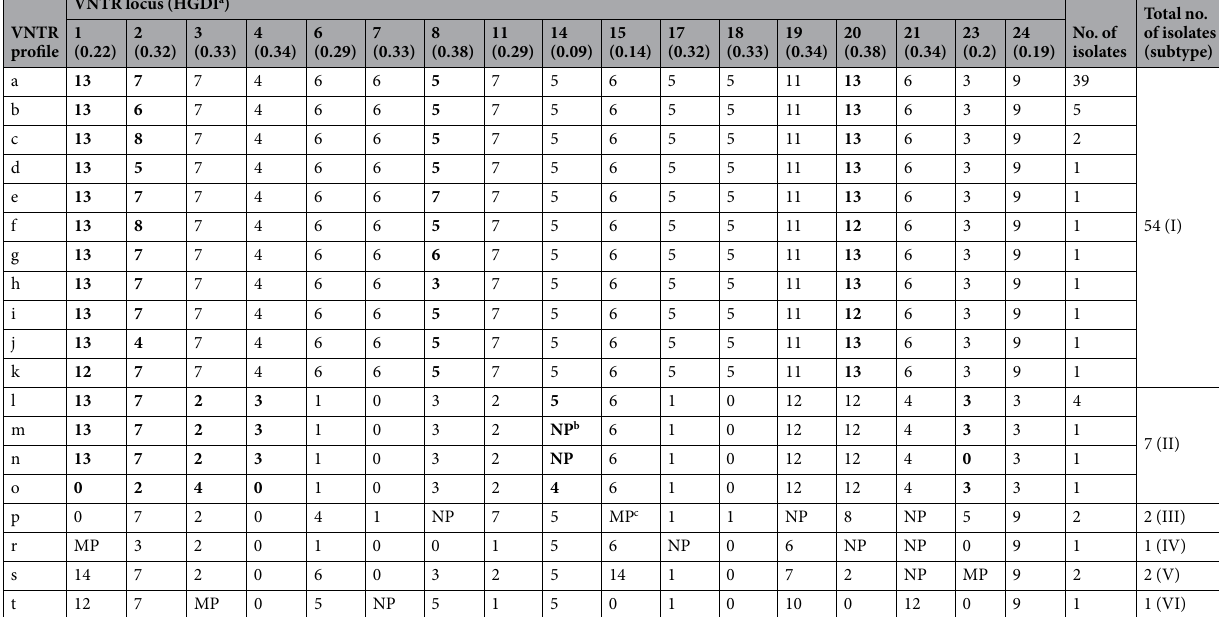
number of copies calculated from the gel analysis of PCR products. Sequence analysis confirmed also the electrophoretically-deduced copy number at locus VNTR 24 for M. kansasii types I, II, and IV and VI. PFGE. Three restriction endonucleases, that is AseI, DraI, and XbaI were attempted in PFGE profiling. Whereas, the latter two consistently resulted in DNA band smearing, thus making the profiles unreadable (data not shown), the use of AseI provided good-quality restriction patterns with clear band separation. PFGE with AseI was performed on the entire study sample (67 isolates). PFGE produced 33 distinct patterns, each consisting of 11–24 bands with sizes ranging between 48.5 to 485 kb. The patterns were separated into 12 clusters, each containing 2–9 isolates, and 21 unique patterns (GDI = 0.49; HGDI = 0.95) (Table 2, Suppl. Figure 1). The CR of the PFGE analysis was calculated at 68.6%. Fifty-four M. kansasii subtype I isolates formed 25 different profiles split into 8 clusters and 17 unique patterns (GDI = 0.46; HGDI = 0.93). Of the clusters, the most abundant were F and H, each comprising 9 isolates (9/54; 16.7%), followed by R and U, of four isolates, each (4/54; 7.4%), M, S, and X, each with three isolates (3/54; 5.6%), and D with two isolates (2/54; 3.7%). Among seven M. kansasii type II isolates, there were two clusters (AC, AE), with two isolates, each (2/7; 28.6%), and three unique profiles (GDI = 0.71; HGDI = 0.9). Type III ( n = 2) and IV ( n = 1) isolates shared identical PFGE pattern (AI), whereas type V ( n = 2) and VI ( n = 1) isolates had type-specific profiles, that is AB and L, respectively. Although some clusters were homogenous with respect to isolate’s geographical origin (e.g. F, R, U, AC, AE), source of recovery (clinical/environmental) (e.g. F, H, R, U, AB), and clinical relevance (e.g. S, AC, AE), clusters allocating isolates of different pathogenic status (F, H, R, U, X), from different countries (H, M, AI, AB) or sources (M, AI) were also observed. Combined analysis. Four (“a”, “b”, “c”, “l”) of the six VNTR clusters were subdivided by PFGE analysis (Table 3 ; Fig. 2). Within a major VNTR cluster “a”, comprising 39 isolates, 23 distinct pulsotypes (A-J, M-Z, AG, AH) could be distinguished. PFGE also differentiated within VNTR clusters “b” (5 isolates), “l” (4 isolates), and “c” (2 isolates), creating three (U, X, AA), two (AC, AE), and two (F, M) pulsotypes, respectively. Contrariwise, of 12 PFGE clusters, nine (D, F, H, M, R, S, U, X, AI) were further separated upon VNTR typing (Table 3). Two major pulsotype clusters (F and H), of nine isolates each, could be subdivided into four (“a”, “c”, “e”, “f”) and two (“a”, “h”) VNTR clusters, respectively. Clusters R and U, each comprising four isolates, were both split into two VNTR clusters (“a”, “j” and “a”, “b”). A three-isolate cluster M and a two-isolate cluster D were split into three (“a”, “c”, “k”), and two (“a”, “d”) VNTR clusters, accordingly. Patterns S, X, and AI, each with three isolates, were subdivided into two different VNTR clusters (“a”, “i”; “m”, “b”; “p”, “r”). A combined VNTR-PFGE analysis resolved 45 distinct patterns, separated into 11 clusters totaling 33 isolates and 34 unique patterns (GDI = 0.67; HGDI = 0.97). The CR of the combined analysis was 49.2%.